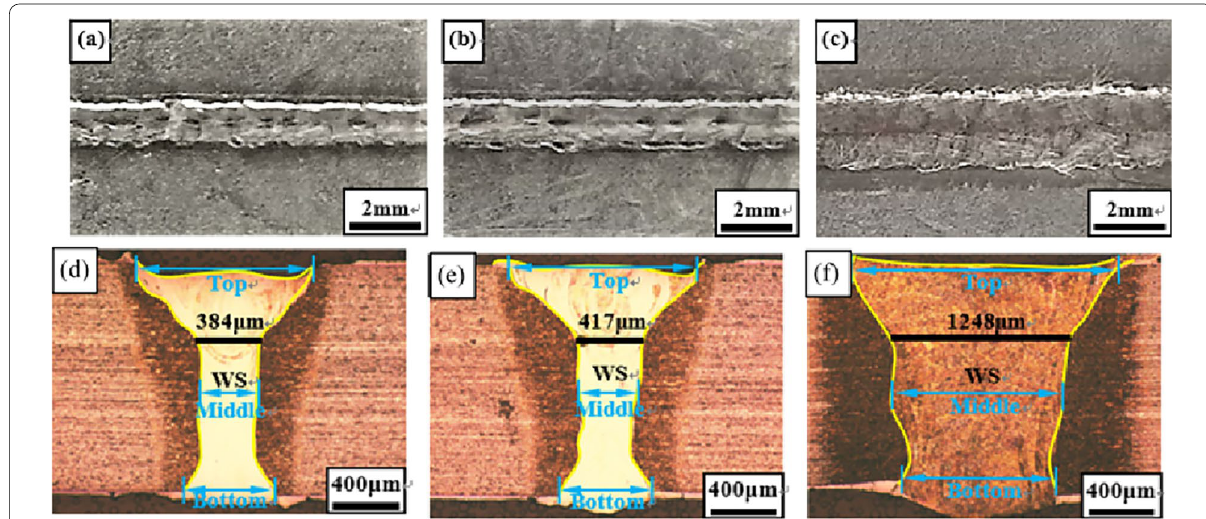
Figure 4 Weld profile with different oscillation amplitudes: a Top surface for without oscillating(A osc , d cross section for without oscillating(A osc A osc = 1.3